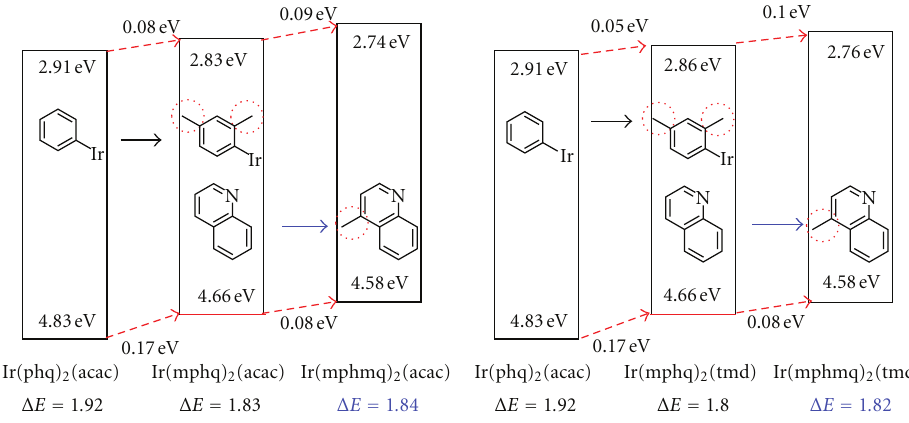
Figure 15: Energy band diagrams of complexes 1–5 from molecular simulation.